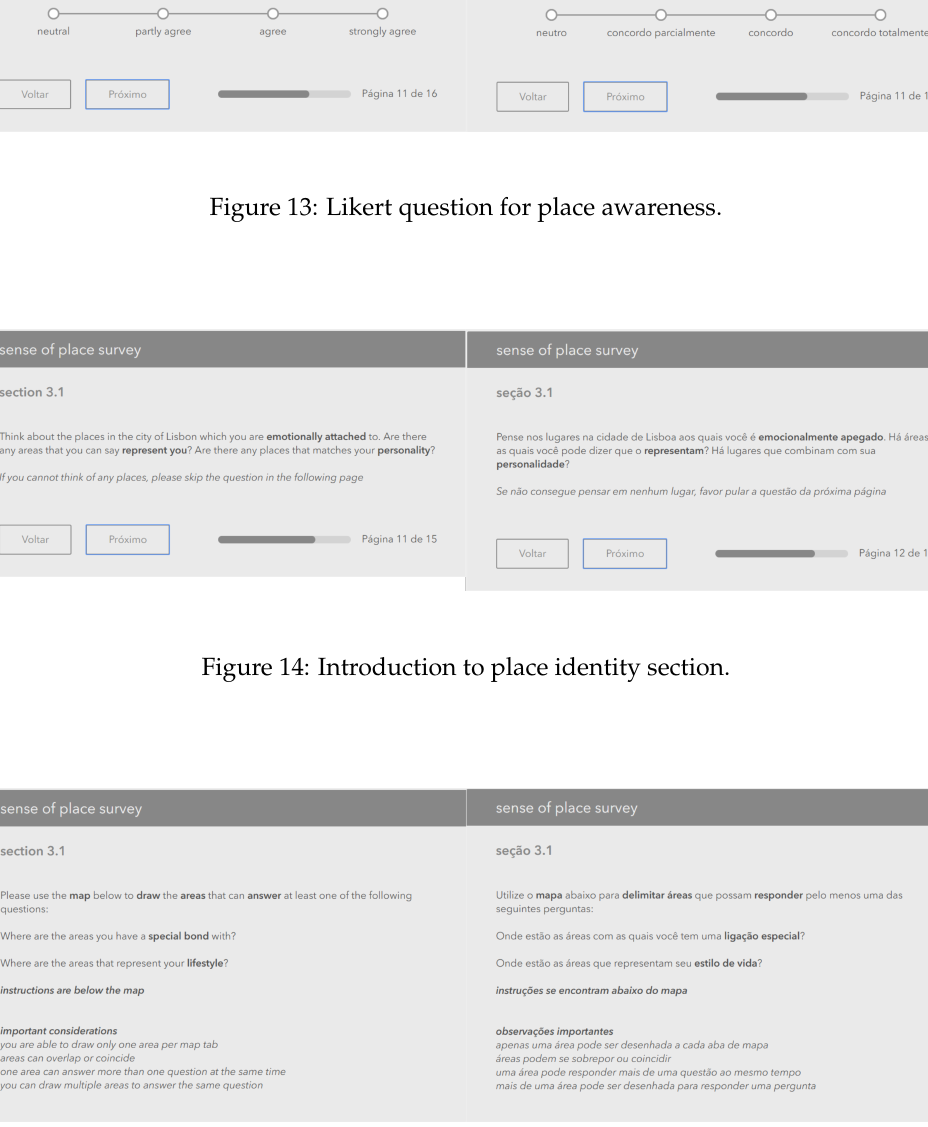
Figure 15: Map-based question for place identity.